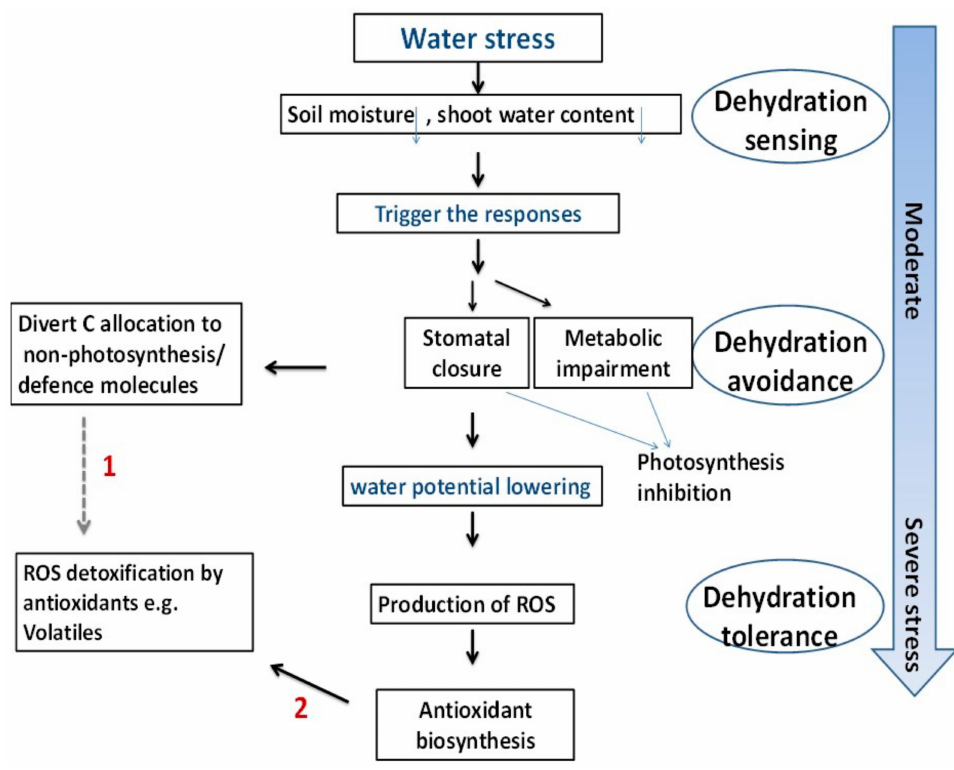
Figure 6. The suggested adaptation mechanisms to drought stress in thyme plants. (1) Pathway illustrates carbon diversion from photosynthesis to VOCs and (2) depicts ROS scavenging by non-enzymatic